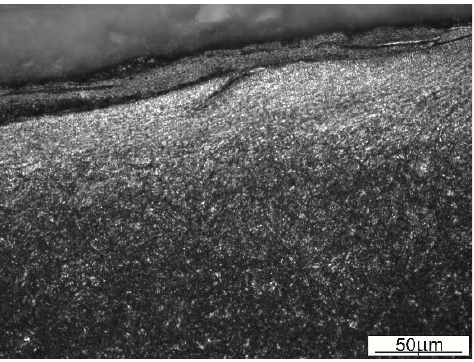
Figure 8. Forged material sticking to the die surface in the area of flash gap.